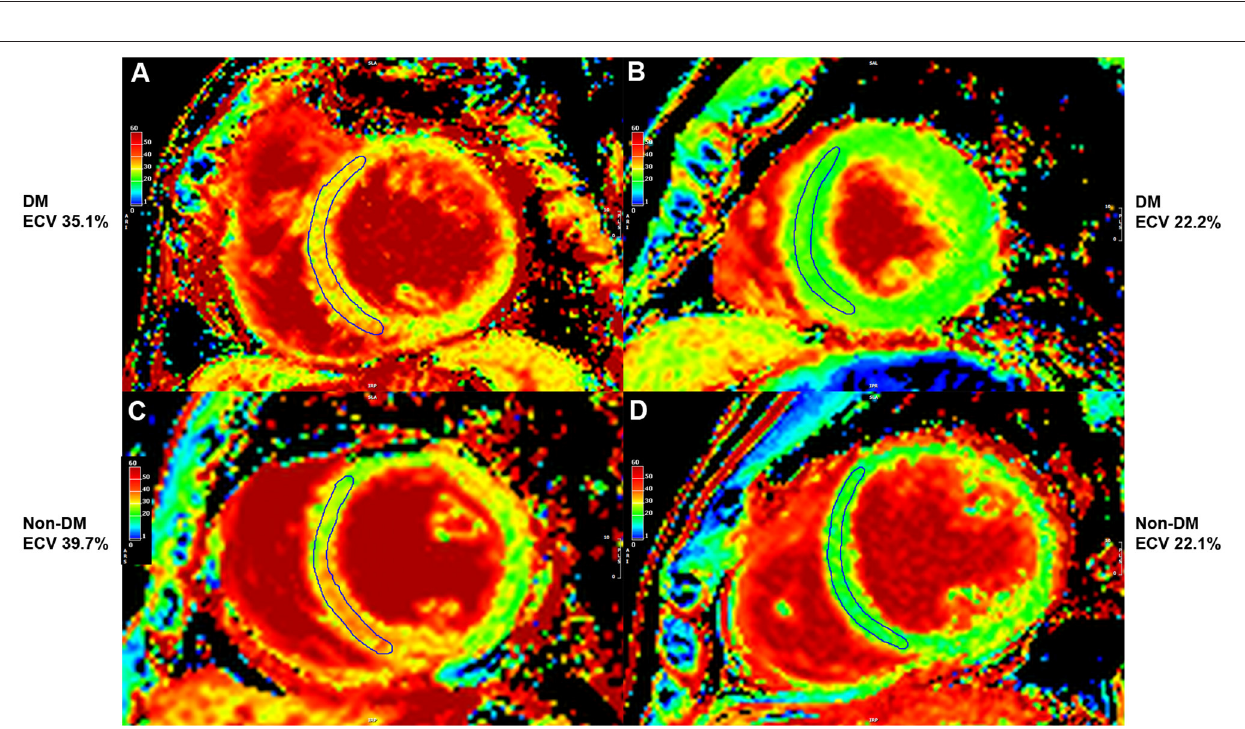
mortality (8). The results of this study prove that patients with T2D have higher ECV, which has a strong negative impact on worse CV outcomes when compared to patients with